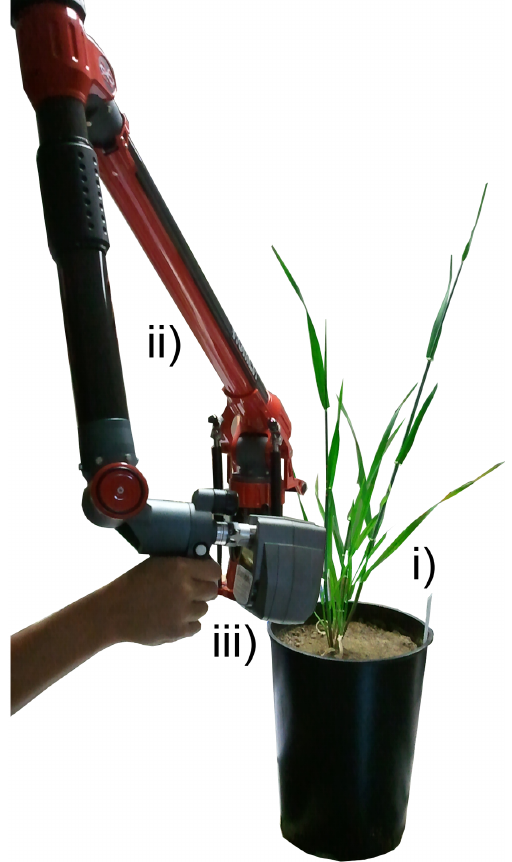
Figure 2. Laser scanning of a barley plant ( i ) using a measuring arm ( ii ) coupled device ( iii ) with a measuring sphere of 1.4 m in radius (Romer Infinite 2.0 and Perceptron V5, Plymouth, MI,